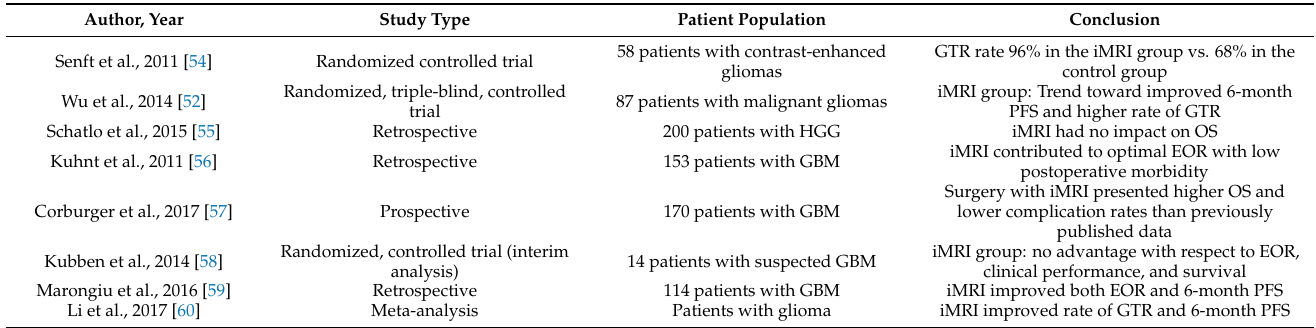
Table 3. Main studies evaluating the use of iMRI in patients with malignant